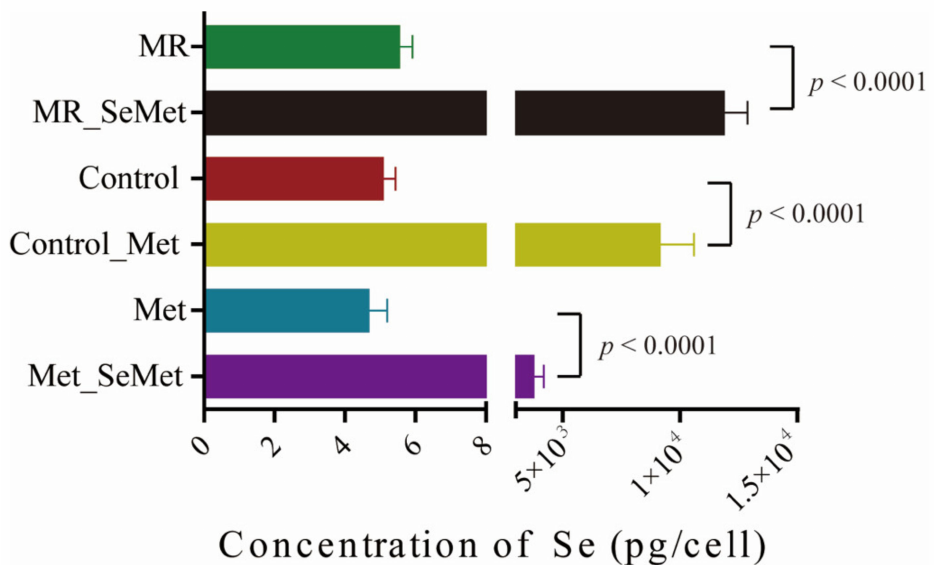
Figure 5. Selenium contents in HepG2 cells after 48-h exposure to SeMet under different Met supply